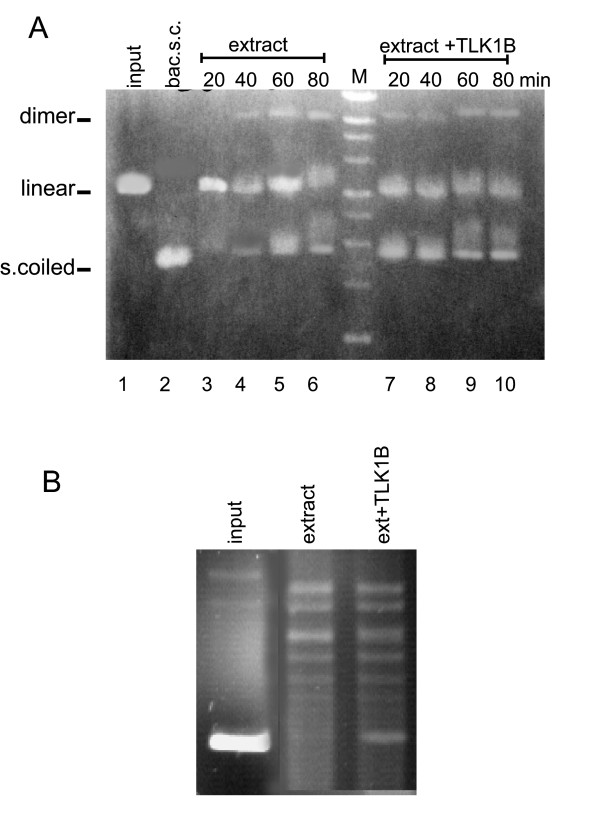
A. Ligation reactions and supercoiling. Reactions were prepared as described Experimental Procedures. The position of linearized plasmid (lane 1, input), bacterial supercoiled (lane 2) and dimers is indicated. The various topomeric forms of supercoiled plasmid (the result of deposition of nucleosomes on the template) are not resolved well in this gel without chloroquine, and appear as a slight smear (lanes 6, 9, 10). B. Assay of chromatin assembly. Nucloesomes assembly was carried out on 2 μg of Bluescript plasmid as described in Methods. Each band corresponds to the addition of one nucleosome, which decreases the linking number. These gels are representative of two different experiments.